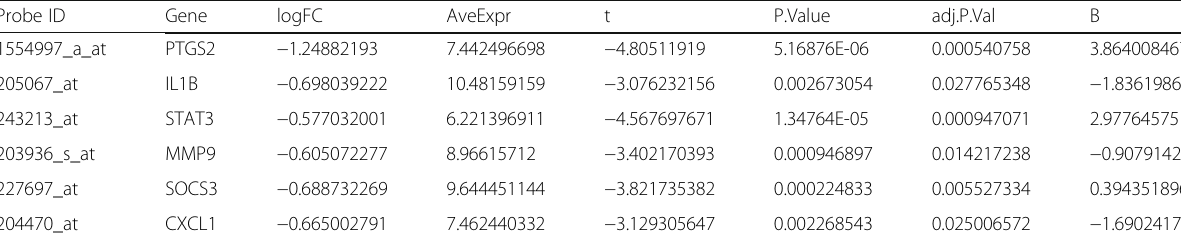
Table 2 Significance levels of the six core genes Probe ID